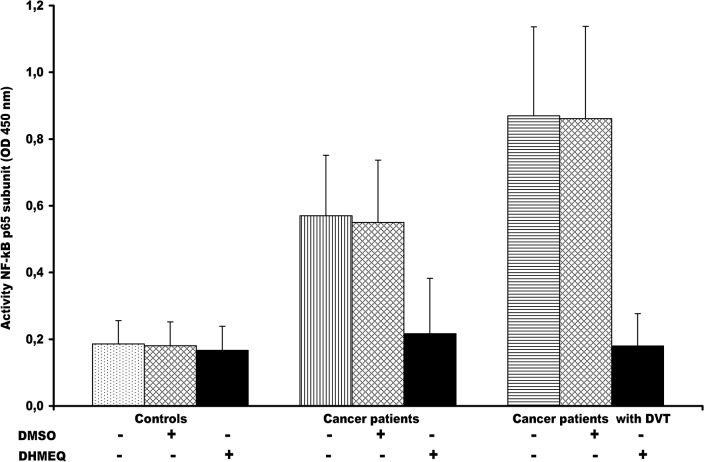
Nuclear factor (NF)–kB p65 subunit activity in monocytes from cancer patients with and without DVT and effect of DHMEQ.The activated NF-kB p65 subunit was significantly higher in cancer patients DVT+ and DVT- than in healthy controls (P< 0.0001). (ANOVA test). NF-kB p65 subunit was significantly higher in cancer patients DVT+ than in those DVT- (P< 0.001) (t-test). To examine the effects of DHMEQ, monocytes were treated with 10 μg/mL DHMEQ. As control experiments, DMSO was used instead of DHMEQ. Monocytes from cancer patients DVT+ were more responsive to DHMEQ than those from DVT-. Intriguingly, no effect of DHMEQ there was in healthy monocytes. The results are shown as the means ± SD. OD, optical density; DVT, Deep Vein thrombosis; DMSO, dimethyl sulfoxide; DHEMQ, dehydroxymethylepoxyquinomicin.